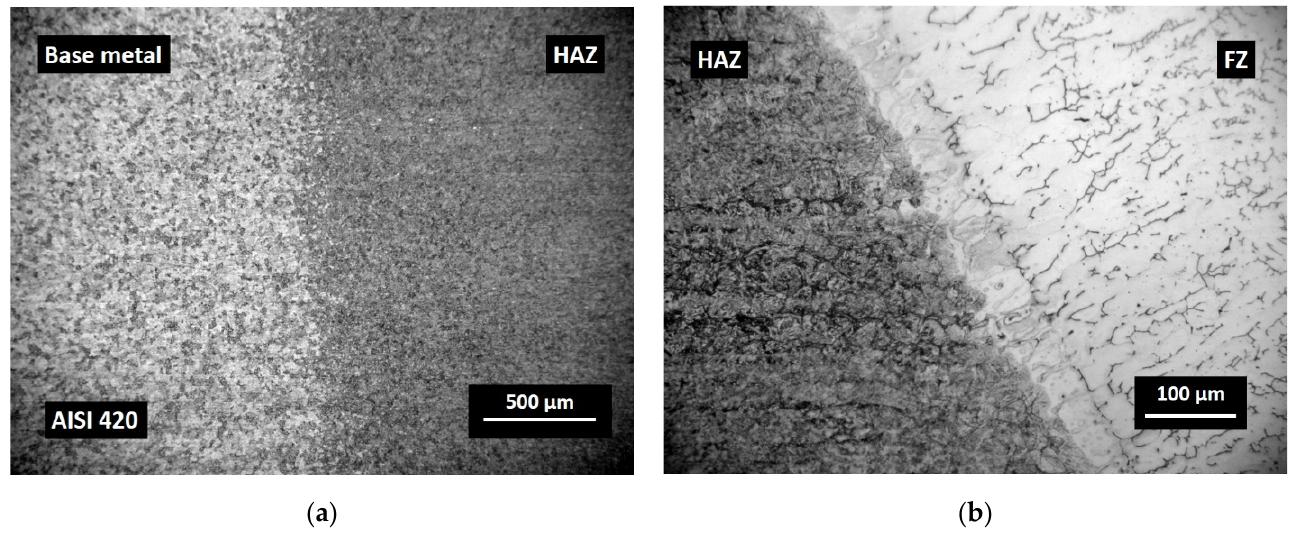
Figure 8. Optical images of AISI 420: ( a ) HAZ with coarse untempered martensite (right) and free tempered martensite in base metal (left); ( b ) partially melted zone AISI 420/FZ.